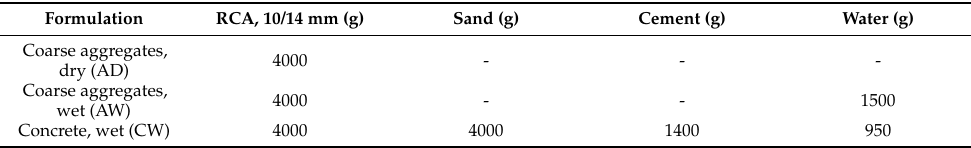
Table 2. Formulations employed in this study.